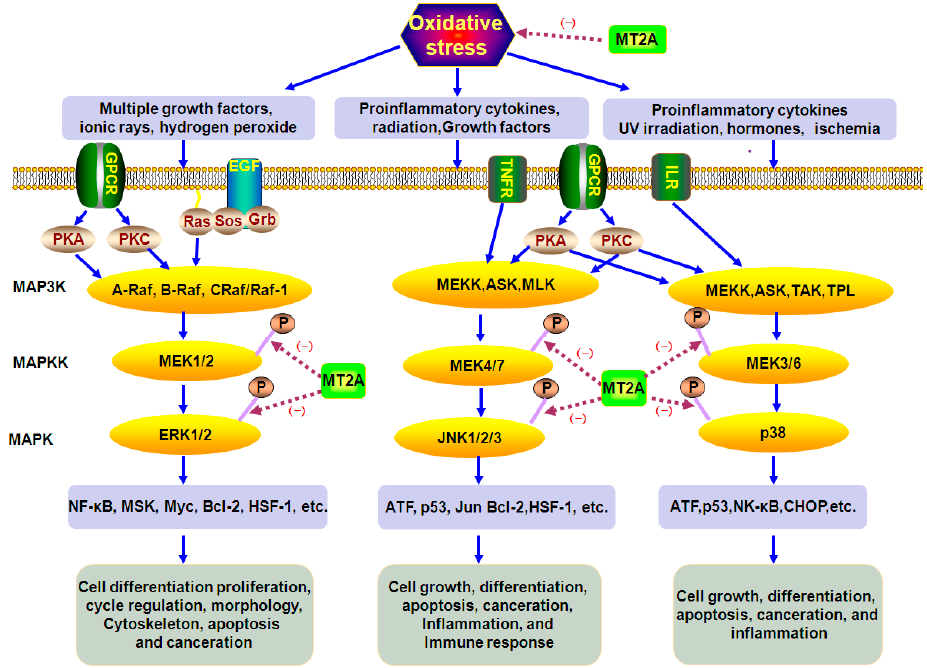
Figure 2. Interactions of subcellular structure during oxidative stress and activation cell apoptosis pathway through mitogen-activated protein kinases (MAPKs). Mammalian metallothionein-2A (MT2A) might inhibit oxidative stress through four subcellular structures. Mitochondrial Stress—MS, Endoplasmic Reticulum Stress—ERS, Lysosomal Membrane Permeabilization Stress—LMPS, Lipid Peroxidation Injury—LPI, Endothelial Nitric Oxide Synthase—eNOS: (green arrows : caused definitely, brown dotted arrows : caused indefinitely, Inhibit( － )).